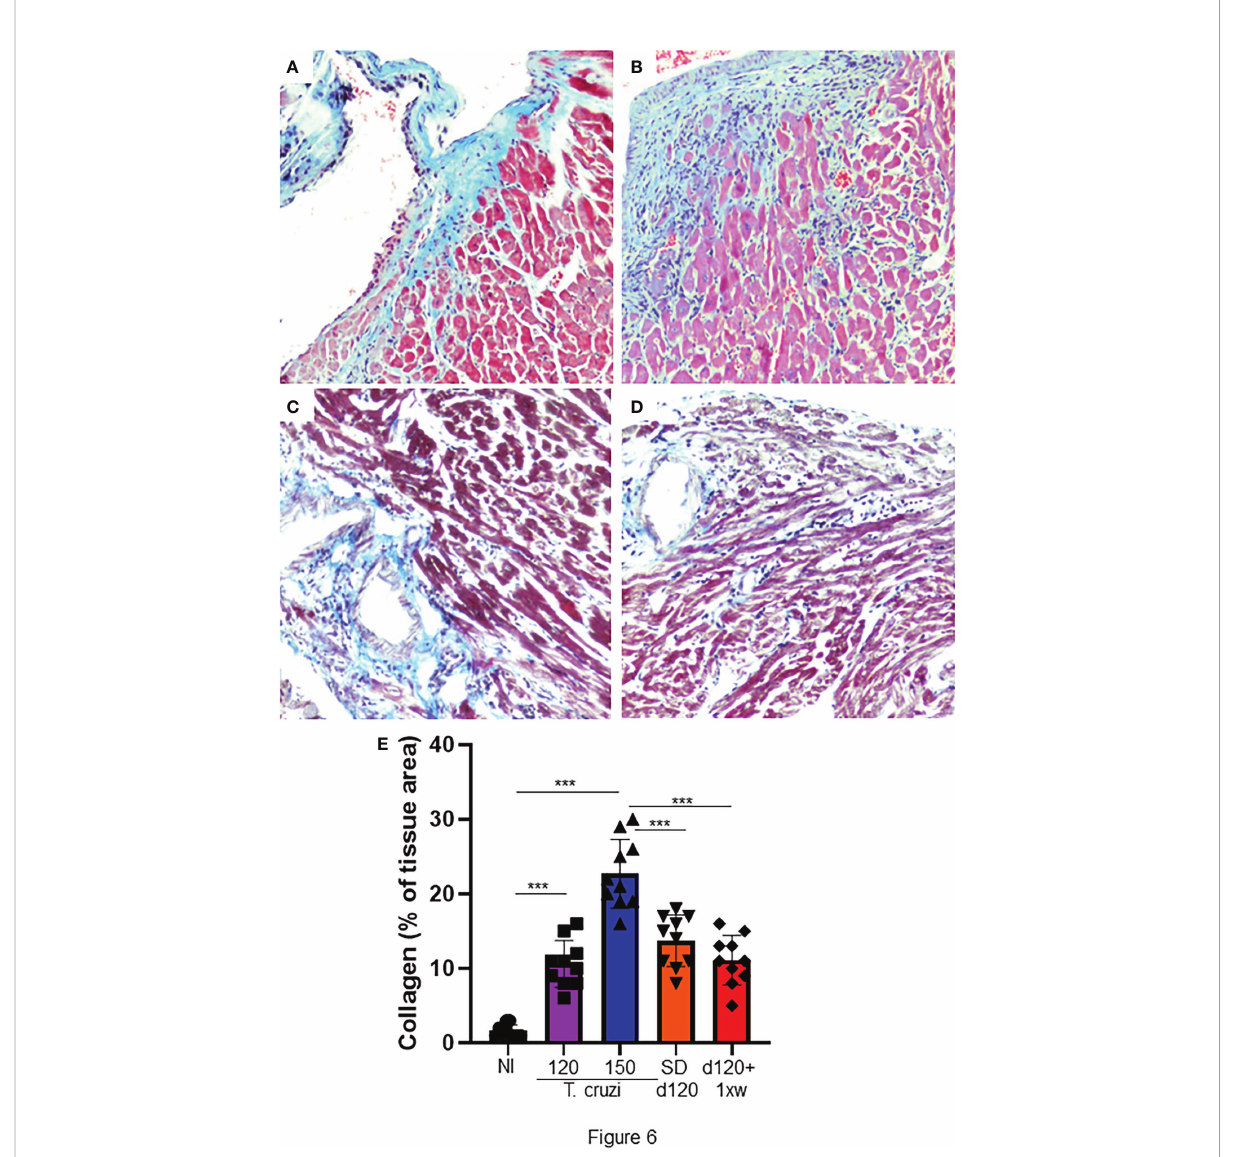
FIGURE 6 1D11 treatment reverses heart fi brosis in mice chronically infected with T. cruzi. After 120 dpi 1D11 was administered in two schemes: (C) a single dose at 120 dpi (SD d120) and (D) starting at 120 dpi + once a week (d120+ 1xw). (A) Non-infected (NI) and (B) infected mice were sacri fi ced at 150 dpi for fi brosis assessment. Heart sections were stained for collagen deposition by Masson ’ s trichrome (light blue staining). (E) Percent of Masson ’ s Trichrome stained area (light blue areas) was quanti fi ed on microscopic images of heart sections using CellPro fi ler image analysis software. Data is a representative image of 10 independent mice per group. Signi fi cant differences between non infected and infected mice treated or not with 1D11 are indicated by ***p <